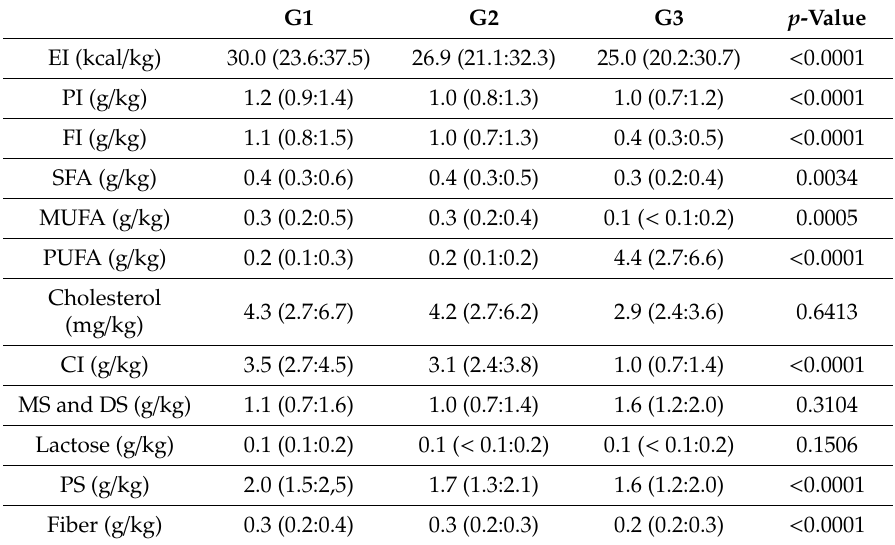
Table 2. Nutritive intake of energy and macronutrients during